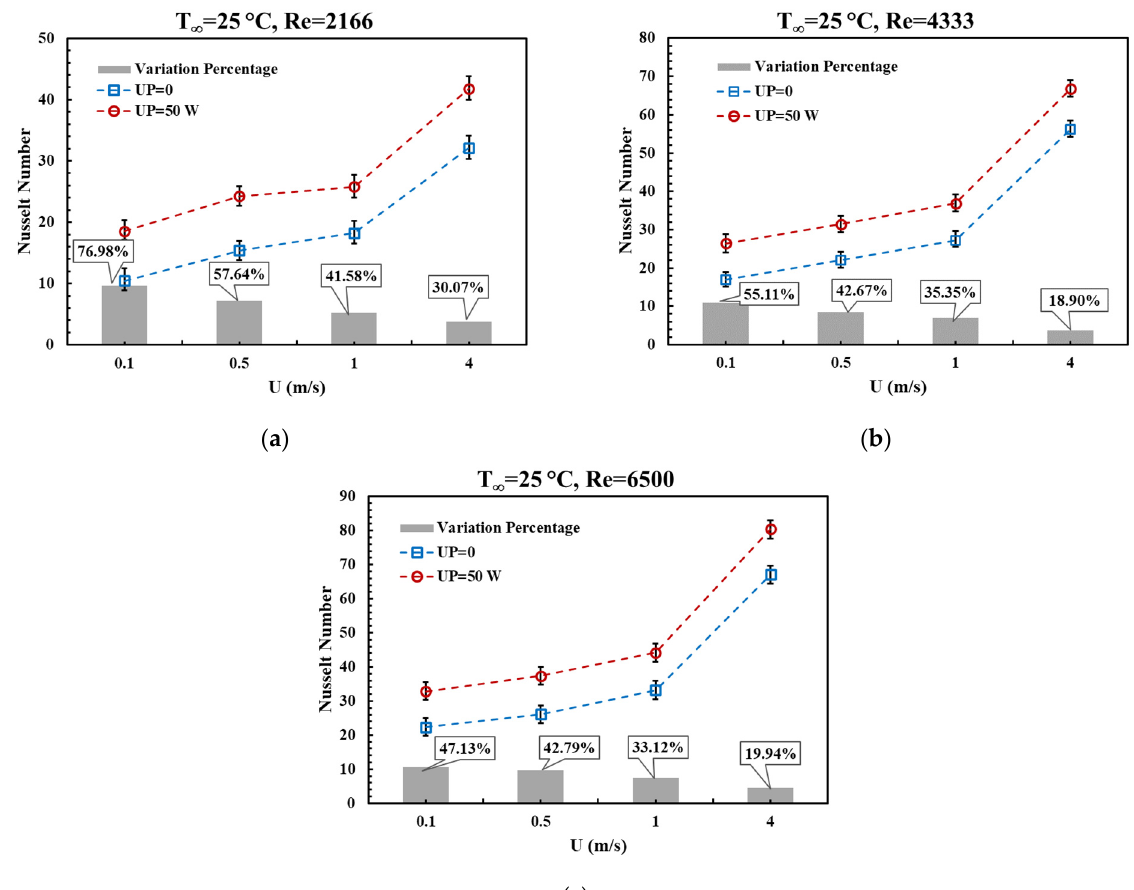
Figure 11. The variations of Nusselt number against U at T ∞ = 25 ( ◦ C ) and Reynolds numbers of ( a ) Re = 2166, ( b ) Re = 4333, and ( c ) Re = 6500. The results are presented in a no-vibration state (UP = 0) and in the presence of vibration with ultrasonic power of 50 Watts (UP = 50 (W)).